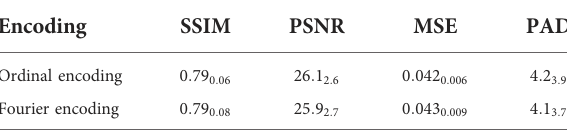
TABLE 1 Quantitative results of brain ageing model using ordinal encoding and Fourier encoding . Encoding SSIM PSNR MSE Ordinal encoding